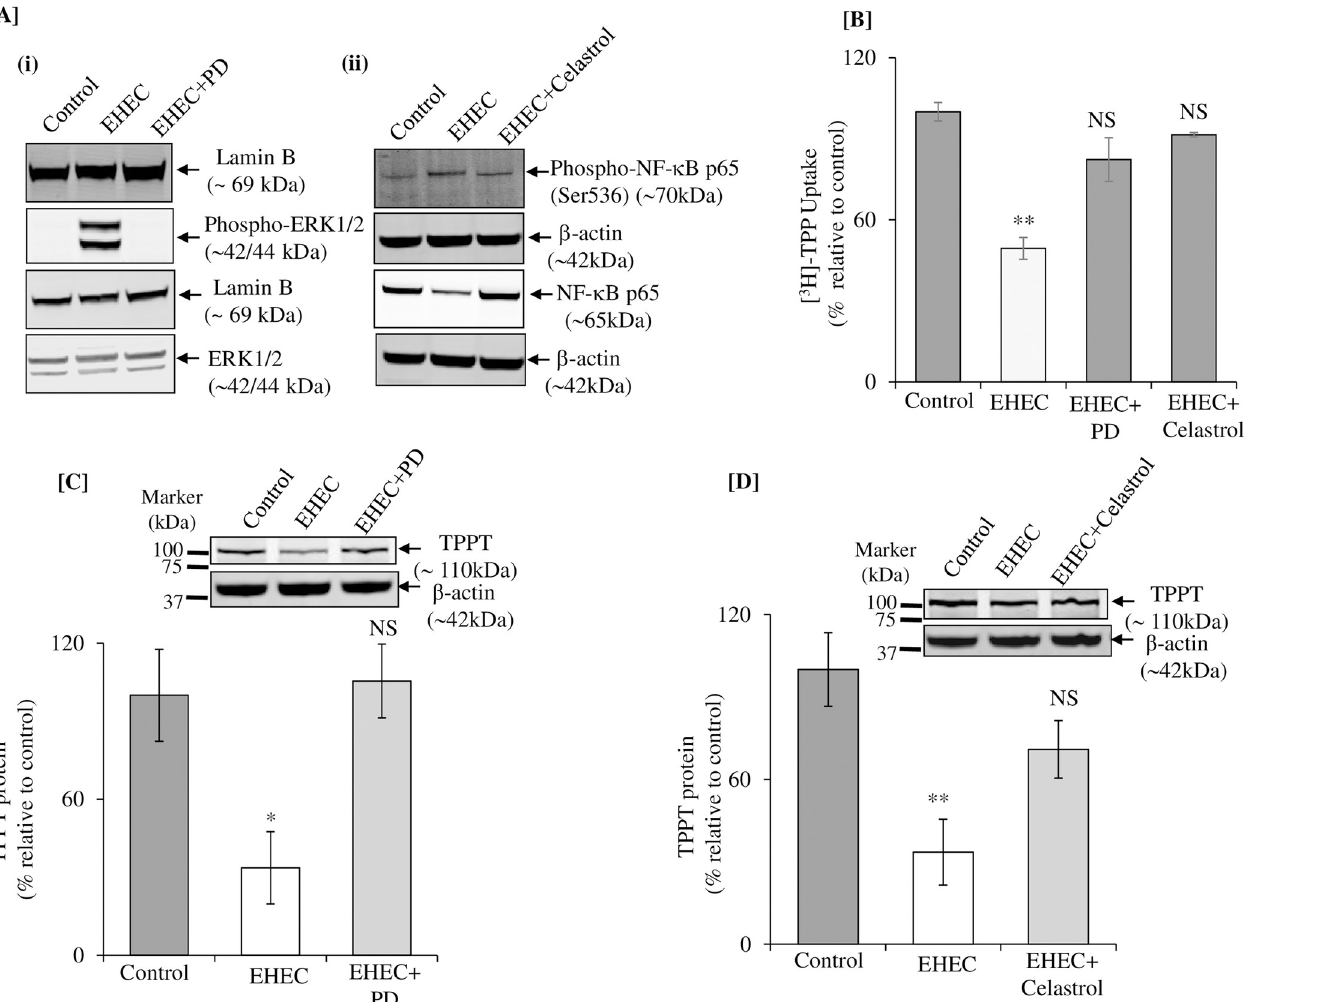
Fig 5. Role of ERK 1/2 and NF- κ B signaling pathways in mediating the effect of EHEC infection of NCM460 cells on TPP uptake and on level of expression of TPPT. [A] Activation of ERK1/2 (i) and NF- κ B (ii) in EHEC infected NCM460 cells. Cells were treated with EHEC and pretreated with 50 μ M PD98059 (an ERK1/2 inhibitor) and 100 nM celastrol (an inhibitor of NF-kB). [B] Carrier-mediated [ 3 H]-TPP uptake was examined in NCM460 cells that were pre-treated with PD98059 and celastrol for 1 h prior to EHEC (200 MOI for 5 h) infection. [C and D] Levels of TPPT protein expression in NCM460 cells that were pre-treated with PD98059 and celastrol prior to EHEC infection, respectively (western blotting). Data are mean ± SE of 4–6 different sets of independent experiments. �� P < 0.01; � P < 0.05; NS-not significant; PD-PD98059 (inhibitor of ERK1/2) and celastrol (inhibitor of NF- κ B).